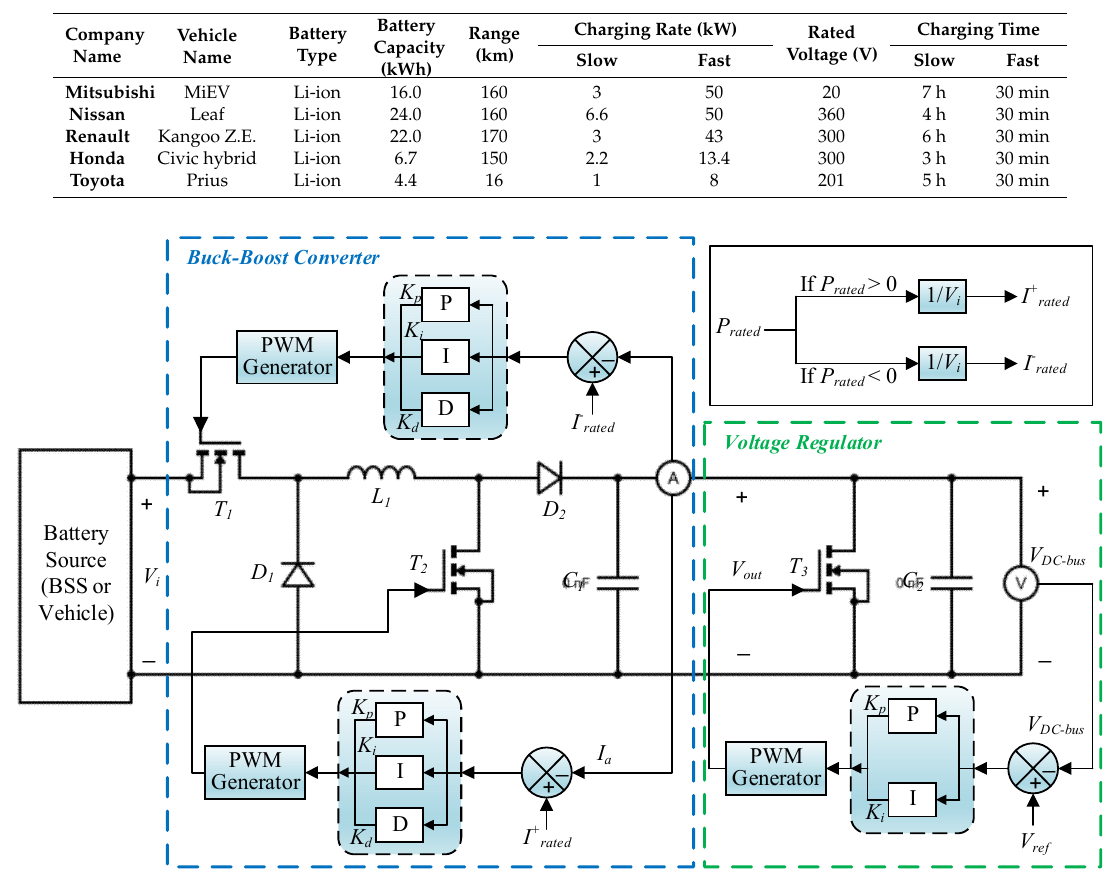
Figure 3. Schematic diagram of a buck boost converter/voltage regulator.